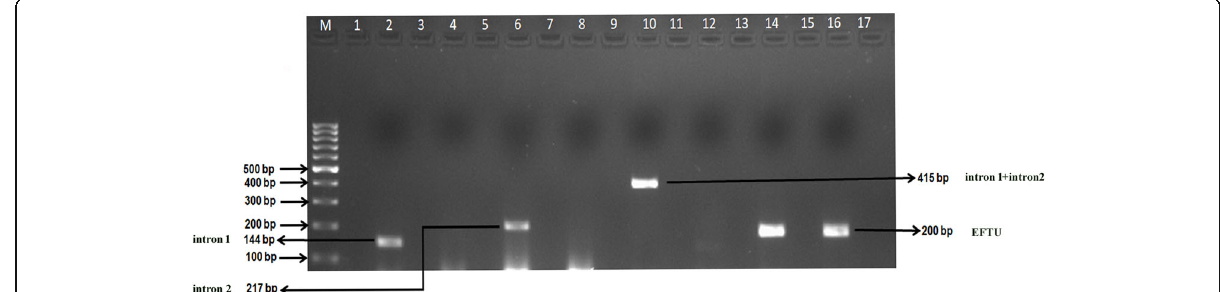
Fig. 8 Validation of intronic regions on 0.8% agarose gel. Lanes 1, 100 bp DNA ladder; lane 2, presence of amplification of the first intron with DNA as template; lane 4, absence of amplification of the first intron with cDNA as template; lane 6, presence of amplification of the second intron with DNA as template; lane 8, absence of amplification of the second intron with cDNA as template; lane 10, presence of amplification of both introns with DNA as template; lane 12, absence of amplification of both introns with cDNA as template; lane 14, presence of amplification of EFTU with DNA as template; lane 16, presence of amplification of EFTU with cDNA as